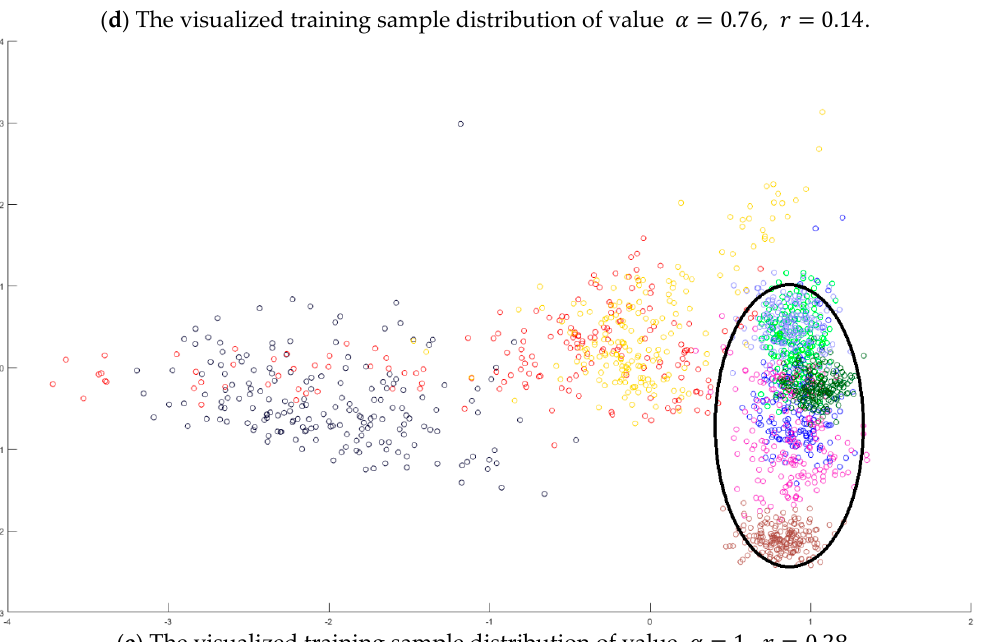
Figure 7. The analysis for the training data in dataset Pavia University: ( a ) The overlapping degrees of various values α , ( b ) The visualized training sample distribution of PCA and r = 0.42, ( c ) The visualized training sample distribution of value α = 0 and r = 0.21, ( d ) The visualized training sample distribution of value α = 0.76 and r = 0.14, and ( e ) The visualized training sample distribution of value 𝛼 =1 and 𝑟 (cid:3404) 0.28 . Table 5. Numbers of pixels on dataset Pavia University.